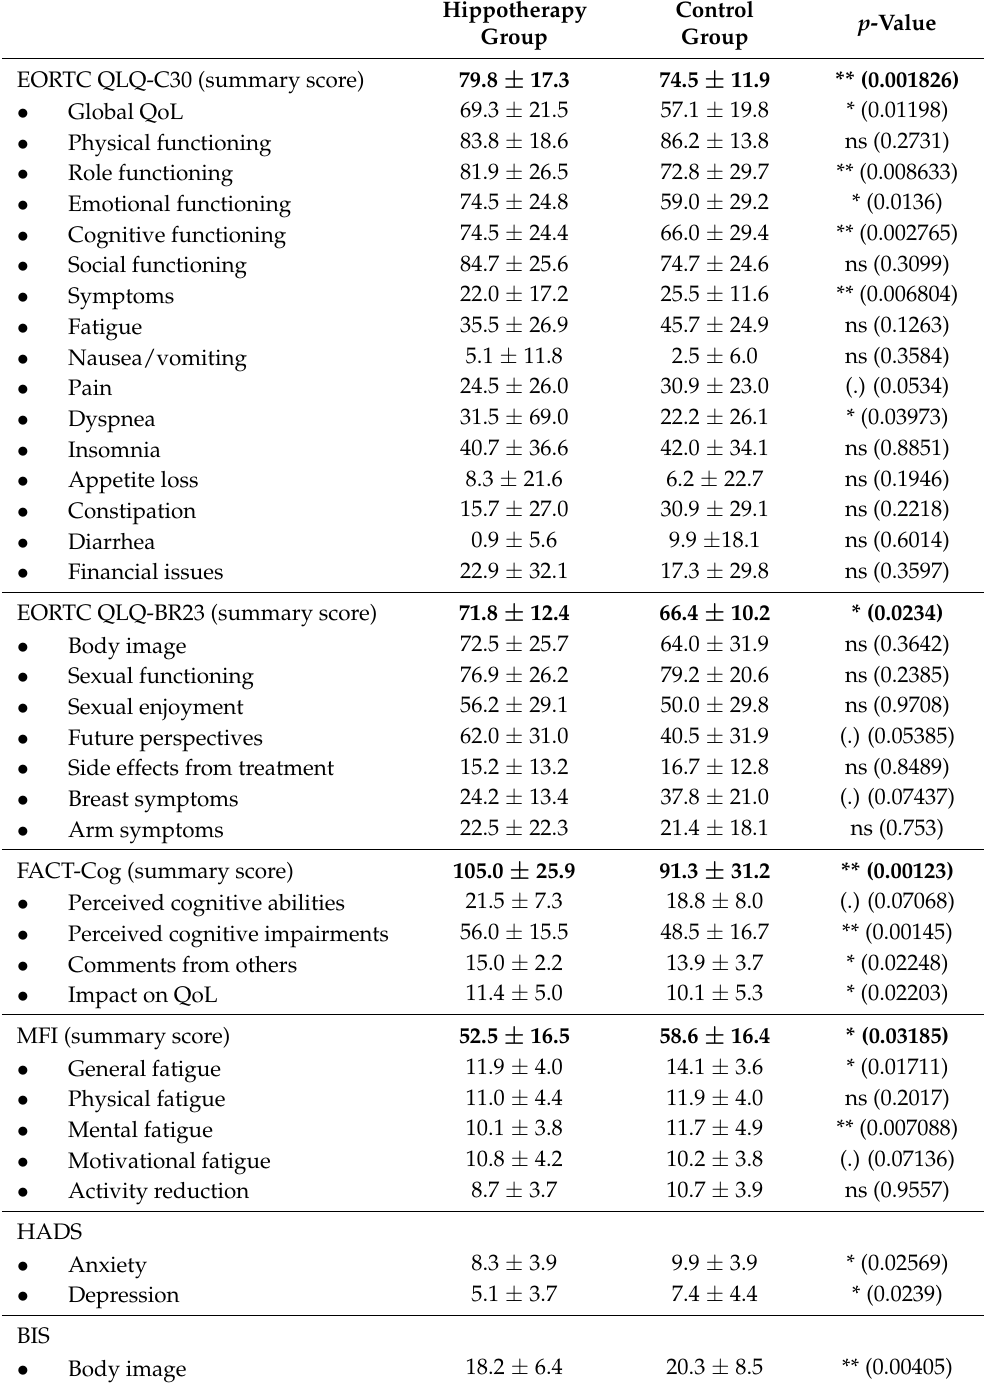
Table A1. Comparison of questionnaires’ summary scores and subsets obtained at baseline between the two groups at Q2. The total scores (summary scores) and item scores for each clinical test (QoL EORTC QLQ-C30 and QLQ-BR23; cognitive function FACT-Cog V3; fatigue assessment MFI-20; anxiety and depression assessment HADS; body image BIS) are provided as means ± standard deviations. p -values correspond to unpaired two-sided Wilcoxon statistics. (ns) non-significant; (.) close to significance (between 0.08 and 0.05); (*) p < 0.05; (**) p < 0.01. Hippotherapy Control p -Value Group Group EORTC QLQ-C30 (summary score) 79.8 ± 17.3 74.5 ± 11.9 69.3 ±